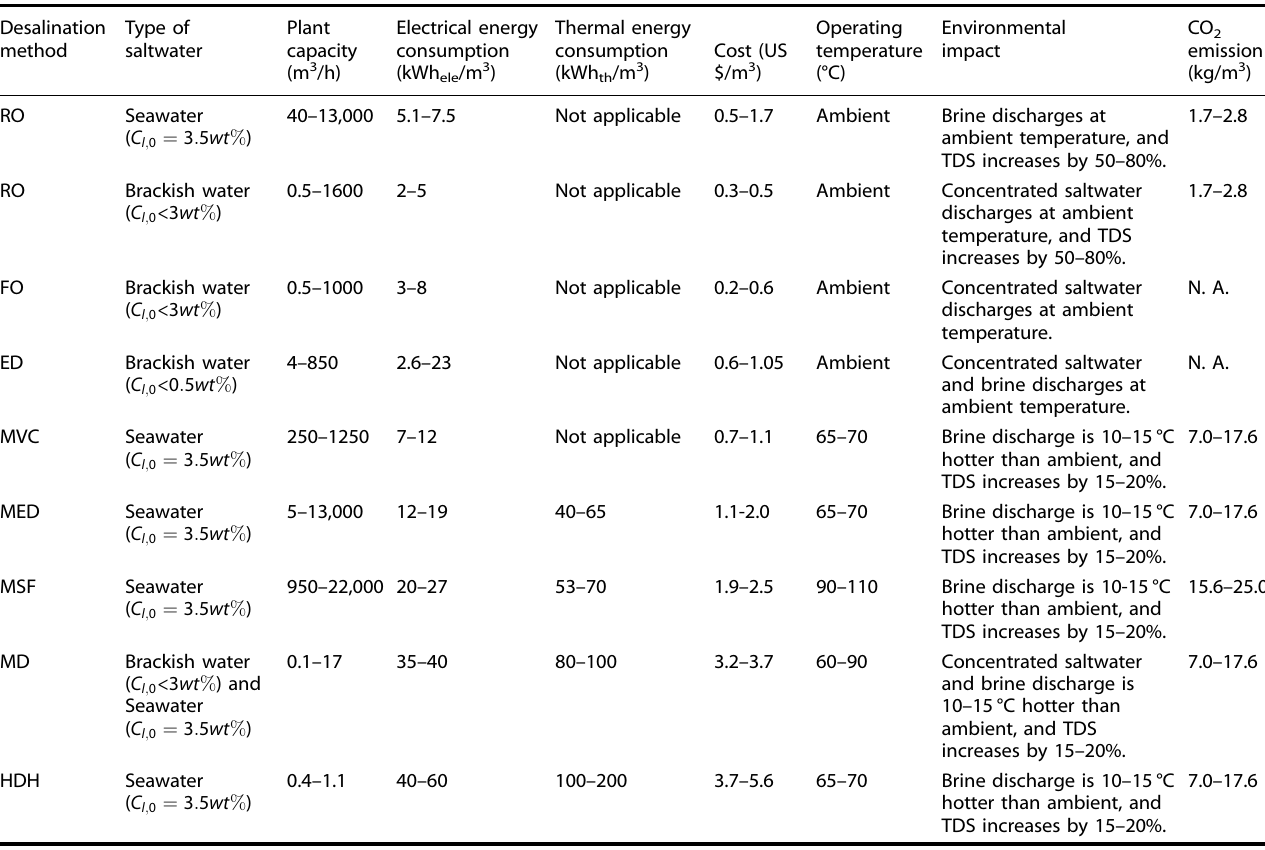
Table 1. Experimental data on potable water production capacity, energy consumption, cost, operating temperature, environmental impact, and CO 2 emission linked with different desalination methods 3 – 14